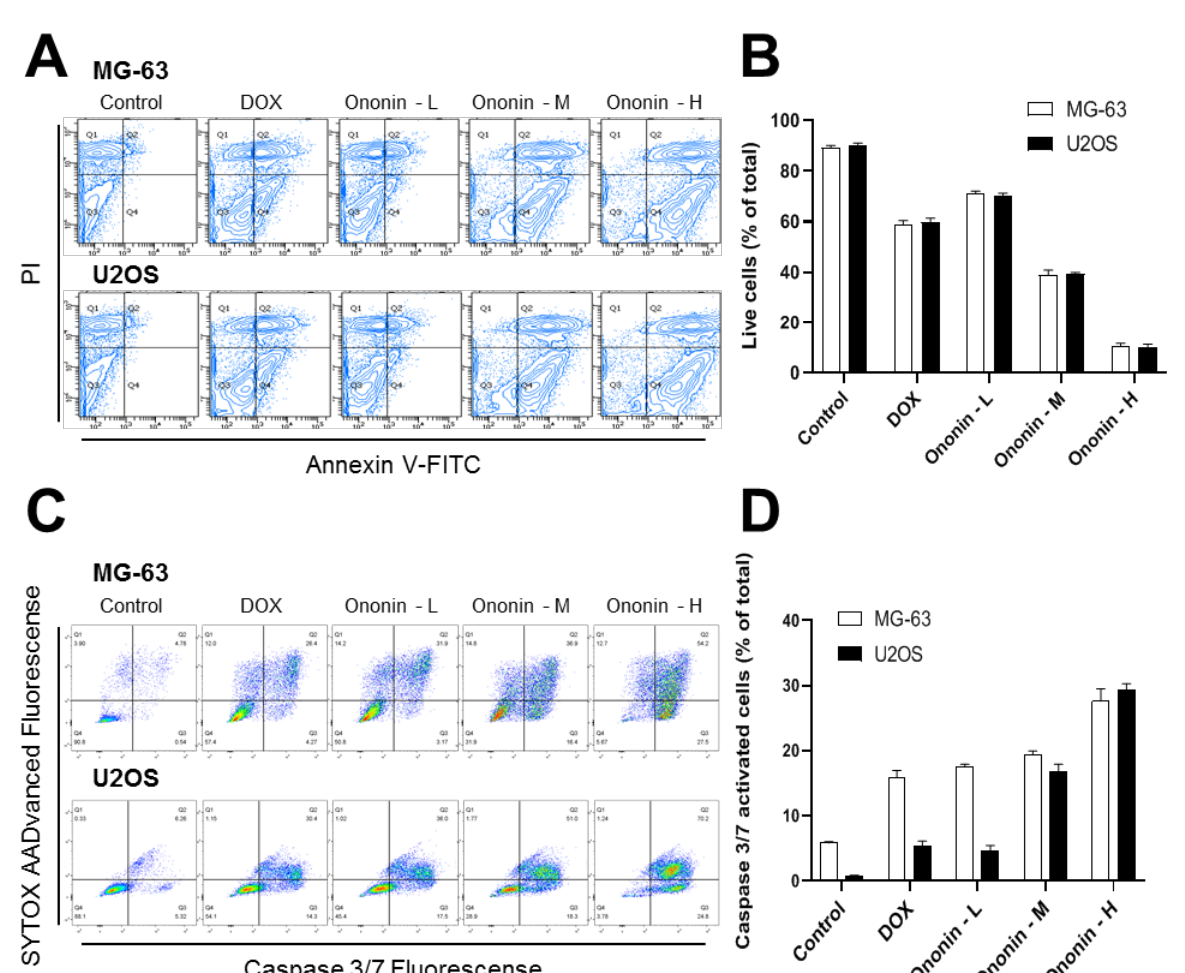
Figure 2. ( A ) The viable cell population was displayed in the bottom left quadrant, the early apoptotic cells in the bottom right quadrant, and the late apoptotic cells in the top right quadrant of the dual parametric dot plots integrating annexin V-FITC and PI fluorescence. ( B ) The quantification analysis was analyzed by the program Flowjo v7.6. ( C ) The dual parametric dot plots combining caspase 3/7 and SYTOX AADvanced fluorescence showed activated caspase 3/7 in the bottom right quadrant (Q4). ( D ) The quantification analysis was conducted by the program Flowjo v7.6. Ononin at 0.1 μM was labeled as - L, 0.3 μM was highlighted as -M, and 1 μM was shown as -H. The values are expressed as the percentage of total cell number, n = 6, in Mean ± SEM. DOX ( 1 μM ) was applied as a positive control.